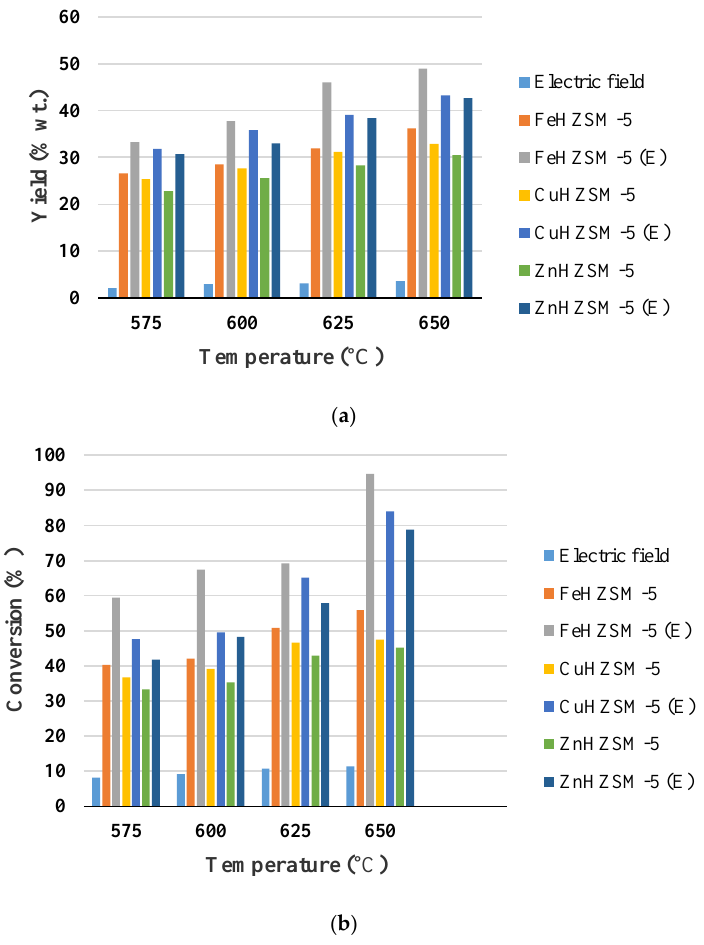
Figure 7. Effect of temperature in oxidative dehydrogenation of LPG for 4 wt. % FeHZSM-5, 4 wt. % CuHZSM-5 and 4 wt. % ZnHZSM-5 catalysts on ( a ) olefin yield; ( b ) LPG conversion: 100 mg catalyst, 6 mA, 10 mm gap distance and 4 wt. % metal loading.